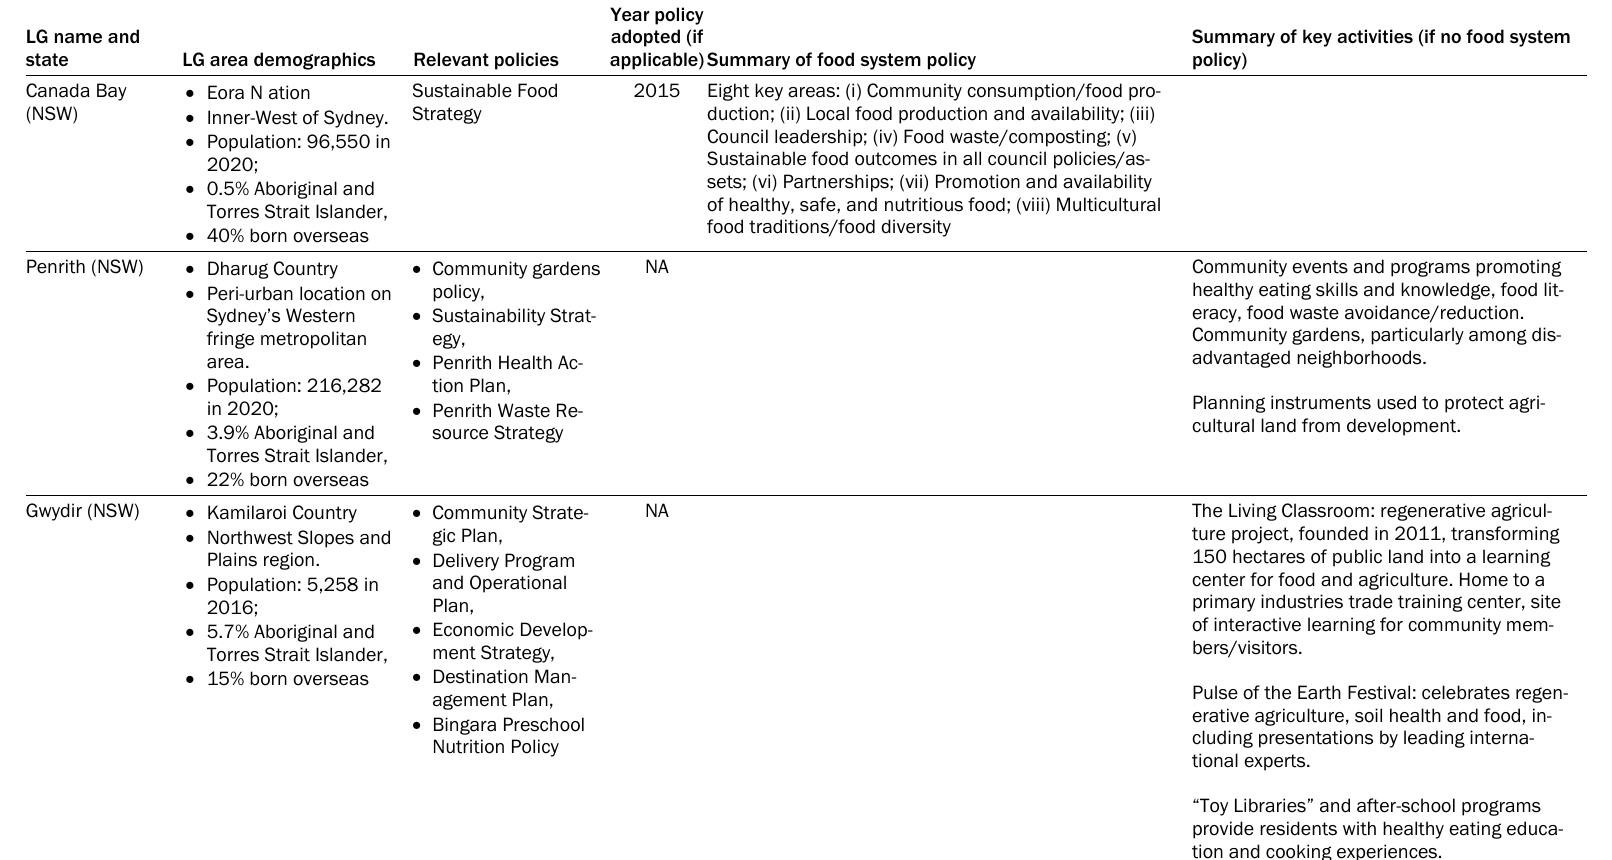
Table 1. Summary of Participating LG Demographics and Food System Policy/Activities LG name and